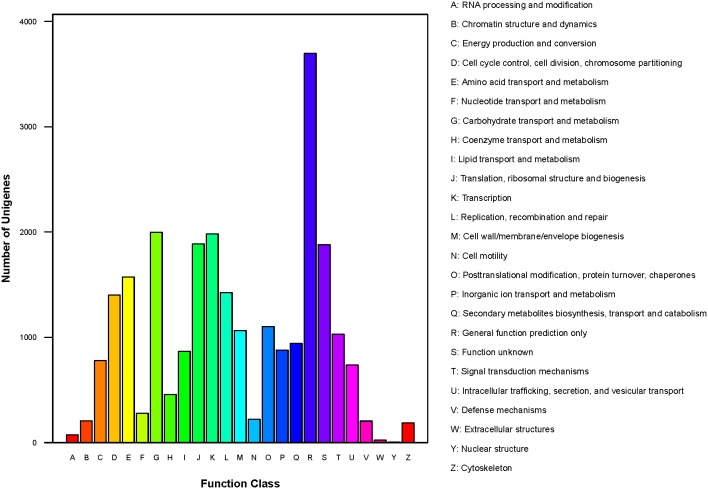
COG classification of P. liquidambari unigenes.